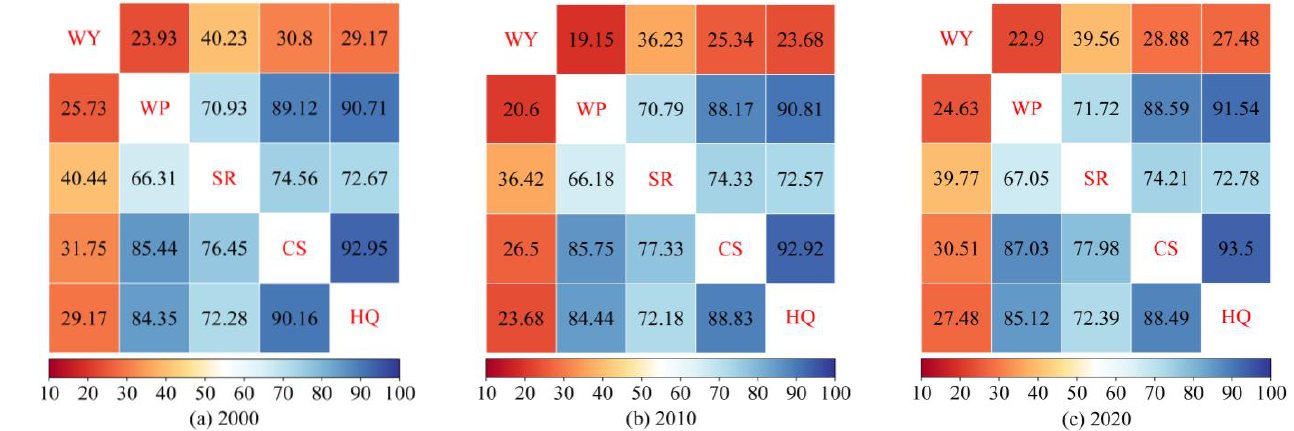
Figure 7. Proportion of overlap of ES hotspots. WP: water purification.